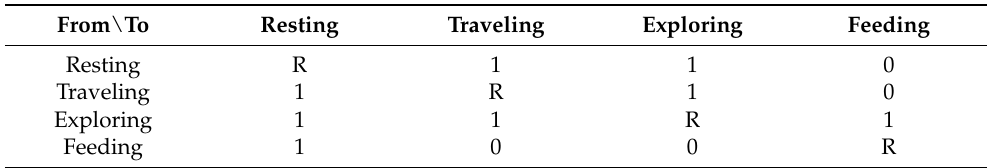
Table 2. Ethogram Matrix, with E b = 1 when modalities are linked, E b = 0 when modalities are not linked and E b = R for the retention ( bi = bj ). From \ To Resting Traveling Exploring Feeding Resting R 1 1 0 Traveling 1 R 1 0 Exploring 1 1 R 1 Feeding 1 0 0 R